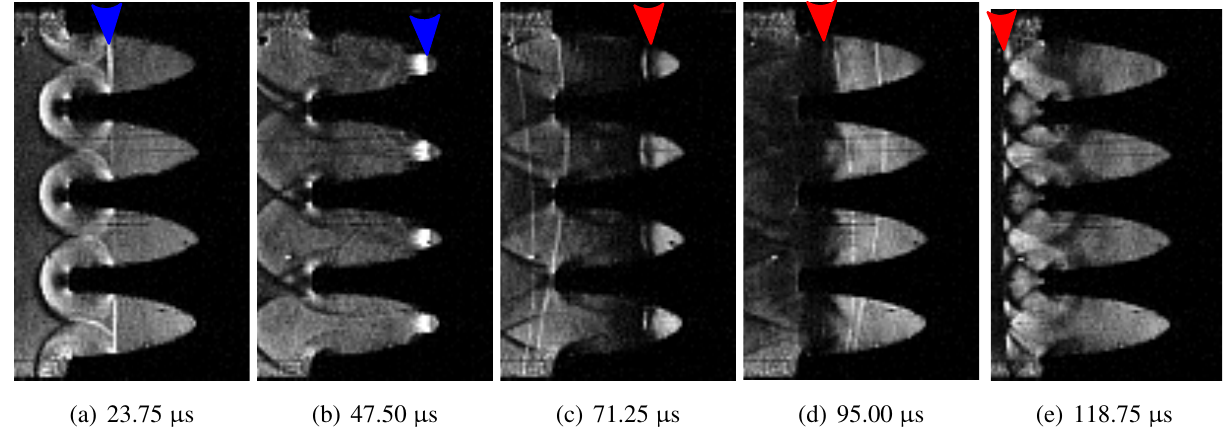
Figure A5. Closed cell foam, Case